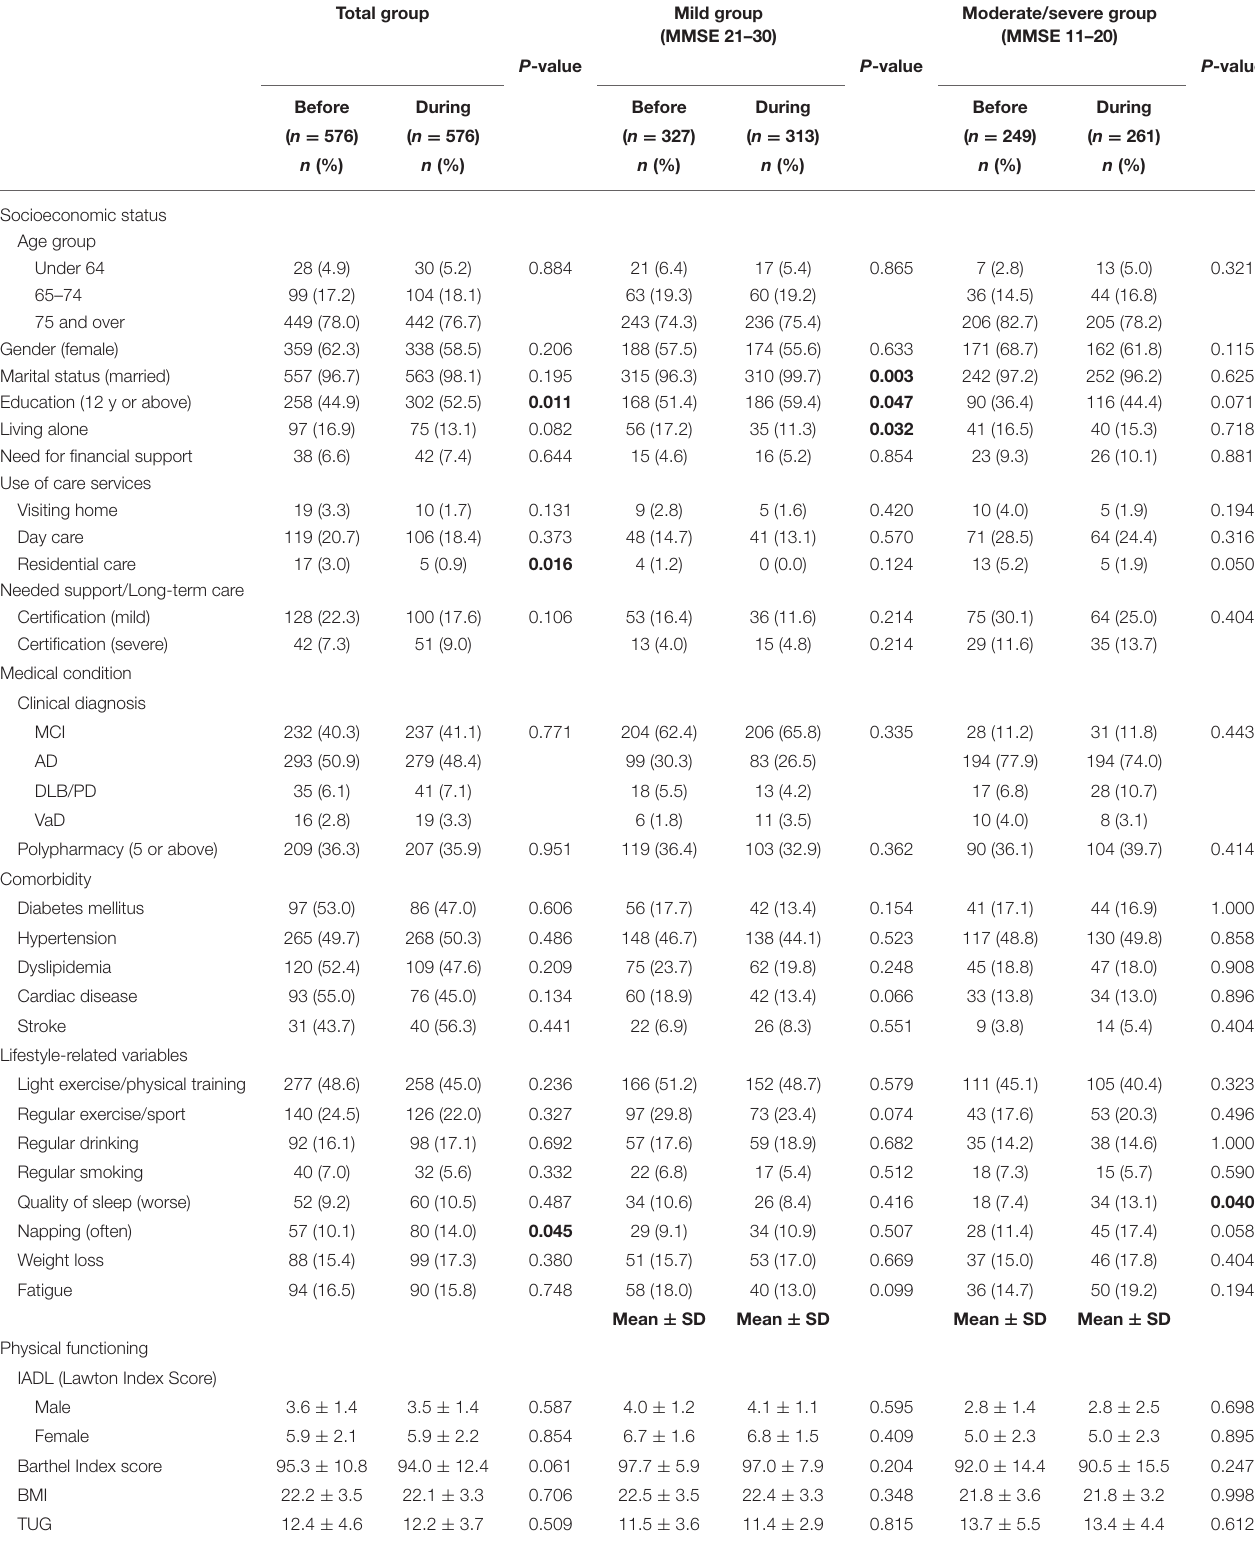
TABLE 1 | Relationship between basic characteristics and lifestyle before and during COVID-19 according to the severity of cognitive impairment. Total